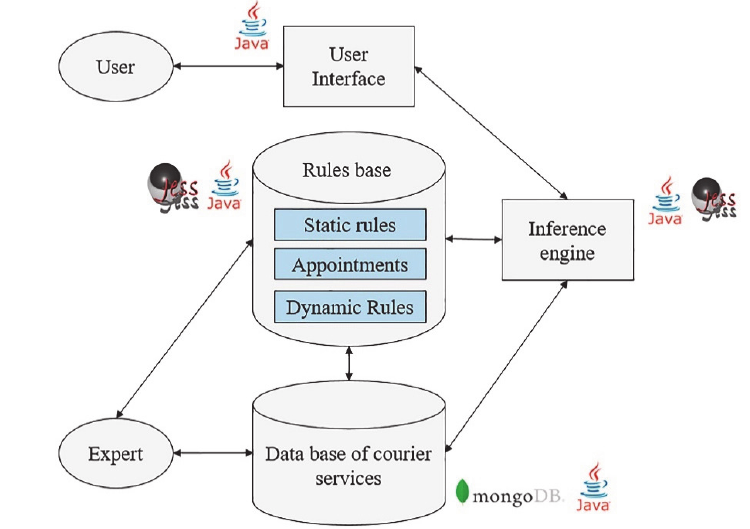
Fig. 3. Architecture of knowledge base and inference